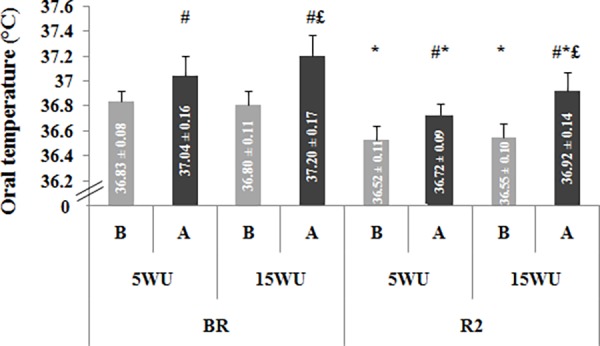
Oral temperature (°C) (mean ± SD, n = 12) recorded before (BR) and during (R2) Ramadan, before (B) and after (A) the 5-minute (5WU) and the 15-minute (15WU) warm-up.#: significant difference in comparison with before warm-up. *: significant difference in comparison with BR. £: significant difference in comparison with the 5-minute warm-up.